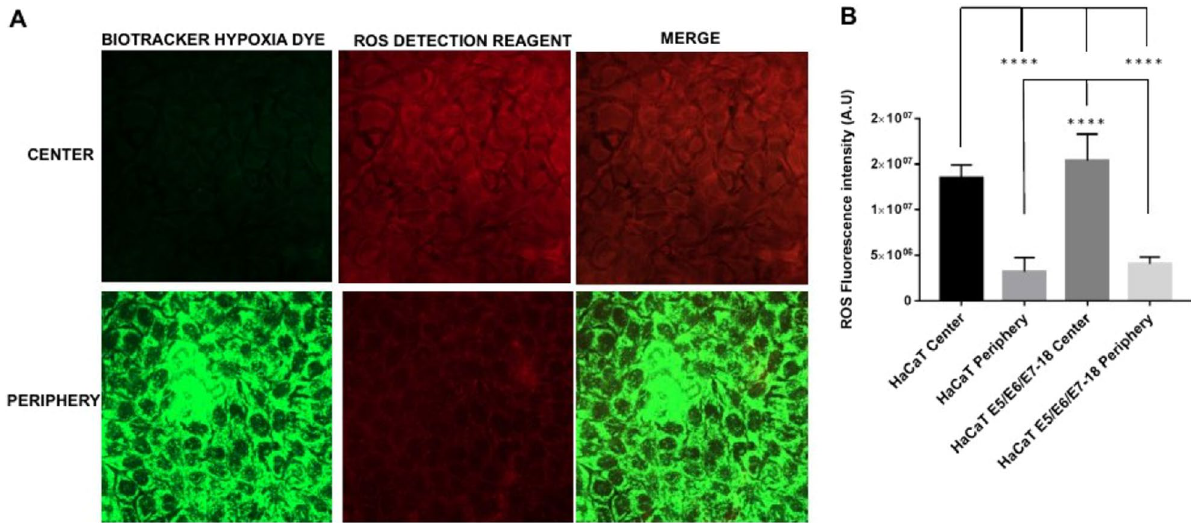
Figure 3. Simultaneous detection of intracellular hypoxia and ROS levels ( A ). Representative images of BioTracker™ 520 Green Hypoxia Dye, and ROS Detection Reagent Deep Red signal in cells under coverslips for 24 h, either in the central zone or the periphery of the cell chamber. ( B ) Quantification of Hypoxia and ROS intensity (mean ± SEM) in normoxia and coverslip conditions for HaCaT parental and HaCaT E5/E6/E7–18